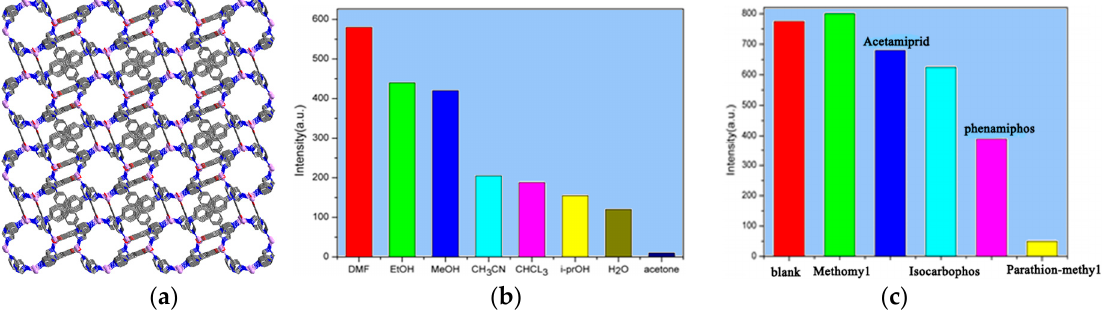
Table 11. Selected examples of MOFs with selective sensing behavior.